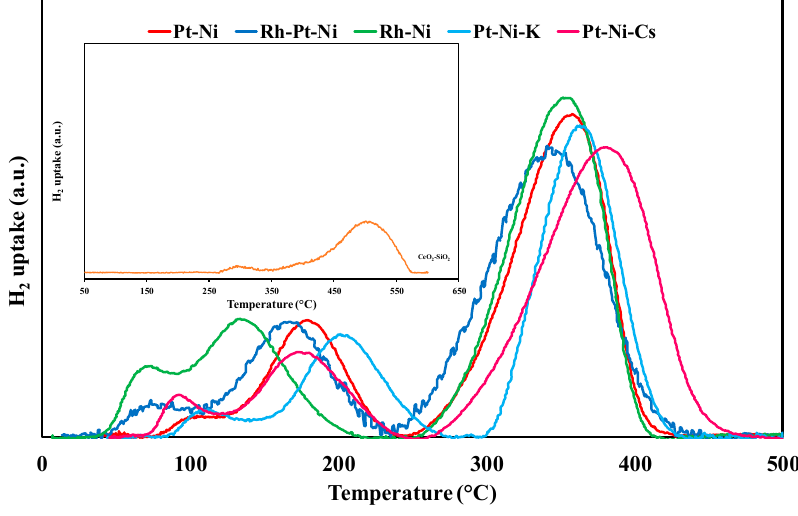
Figure 2. H 2 consumption profiles of the CeO 2 -SiO 2 based catalysts; (insertion: H 2 consumption over the bare support).